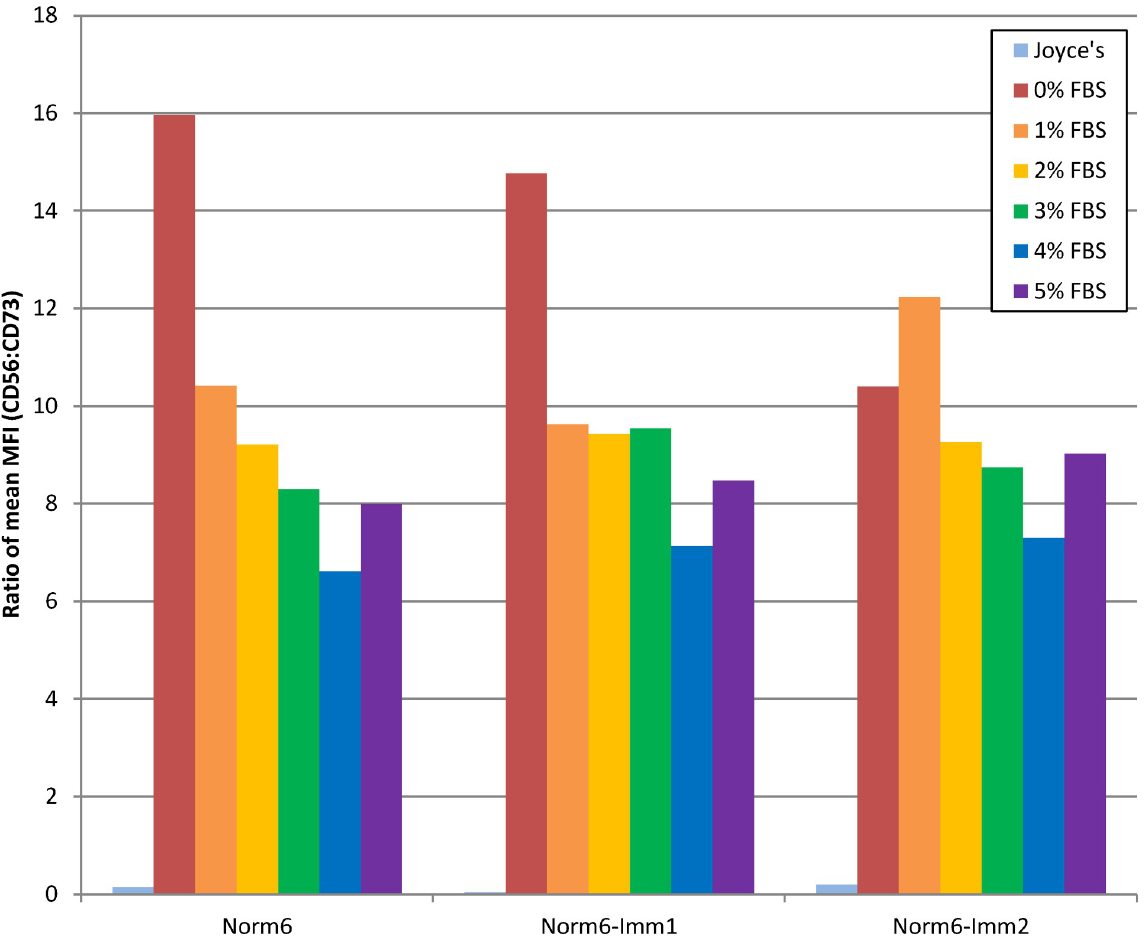
Fig 6. Expression ratios of CD56 and CD73 from normal and hTERT immortalized HCECs matured in various concentrations of FBS. Two independent immortalized cell lines (Norm6-Imm1 and Norm6-Imm2) were established from Norm6. CD56 and CD73 expression was analyzed by flow cytometry and the mean fluorescent intensity (MFI) of CD56 and CD73 for each line was used to generate the CD56:CD73 ratio. S1 Table contains individual MFI values.